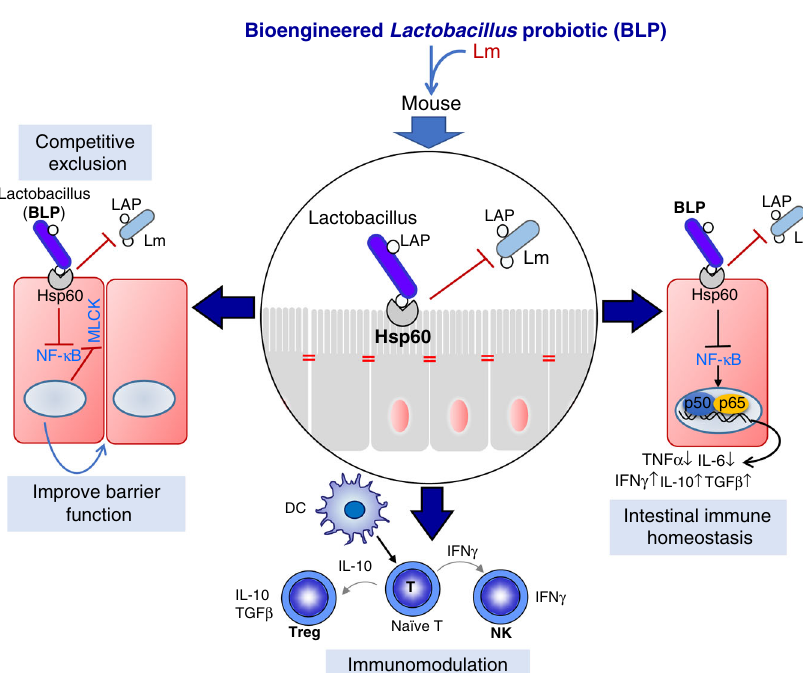
Fig. 10 Schematics showing the mechanism of BLP-mediated protection against listeriosis. The BLP prevents Lm Infection by three mechanisms (i) competitive exclusion, (ii) improved intestinal barrier function, and (iii) contact-dependent